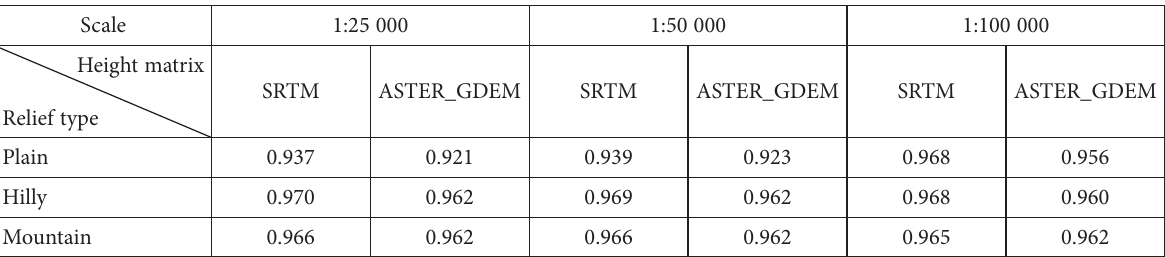
Table 4. The correlation matrix of raster surfaces